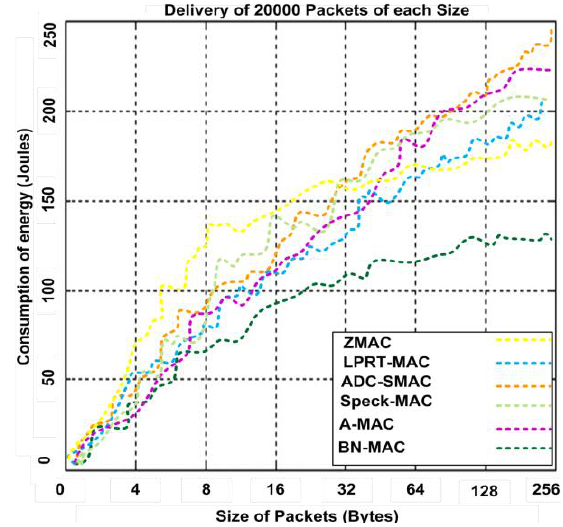
Figure 20. Energy consumption with variable packet sizes.